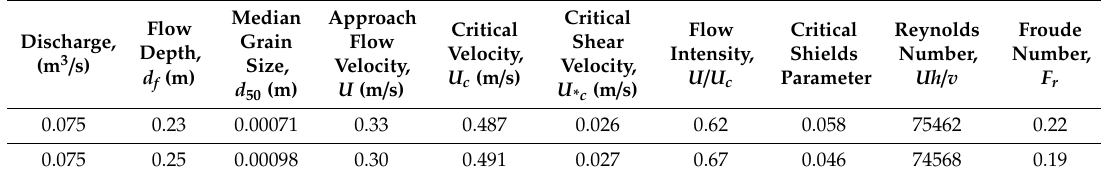
Table 1. Flow parameters for sand